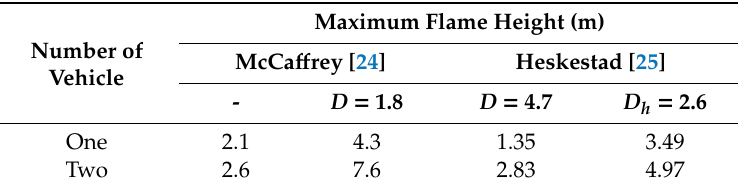
Table 3. Comparison of flame heights under the open condition.